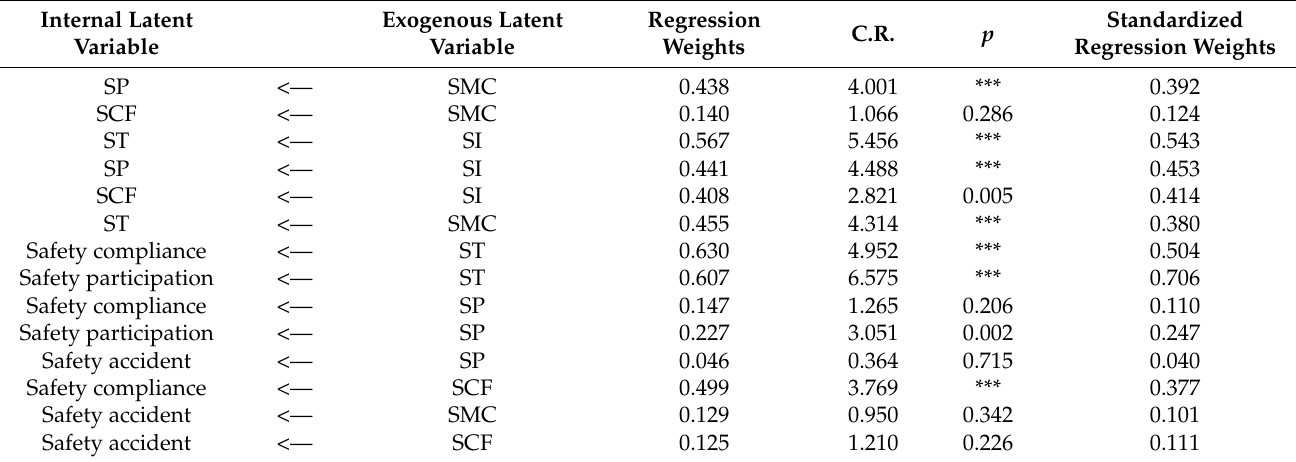
Table 3. The standardized path coefficients of the second